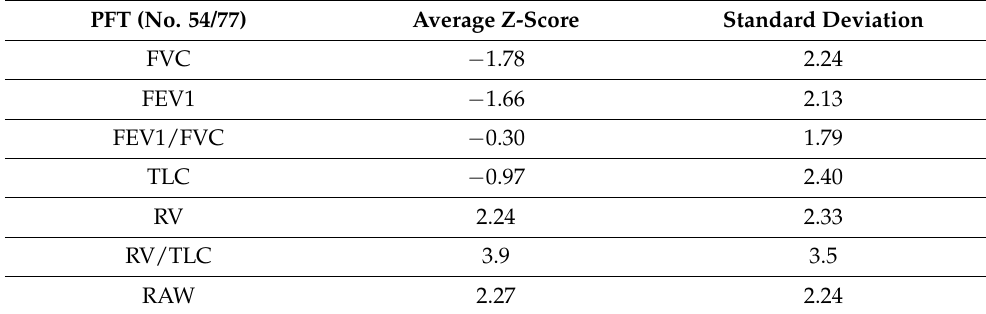
Table 3. Pulmonary function tests